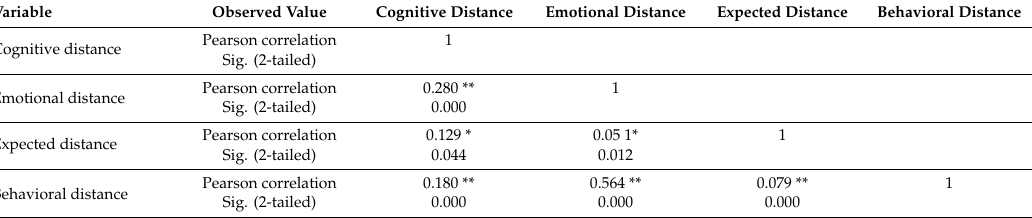
Table 3. Correlation analysis of public cognitive / emotional / expected / behavioral distance towards occupational safety and health.